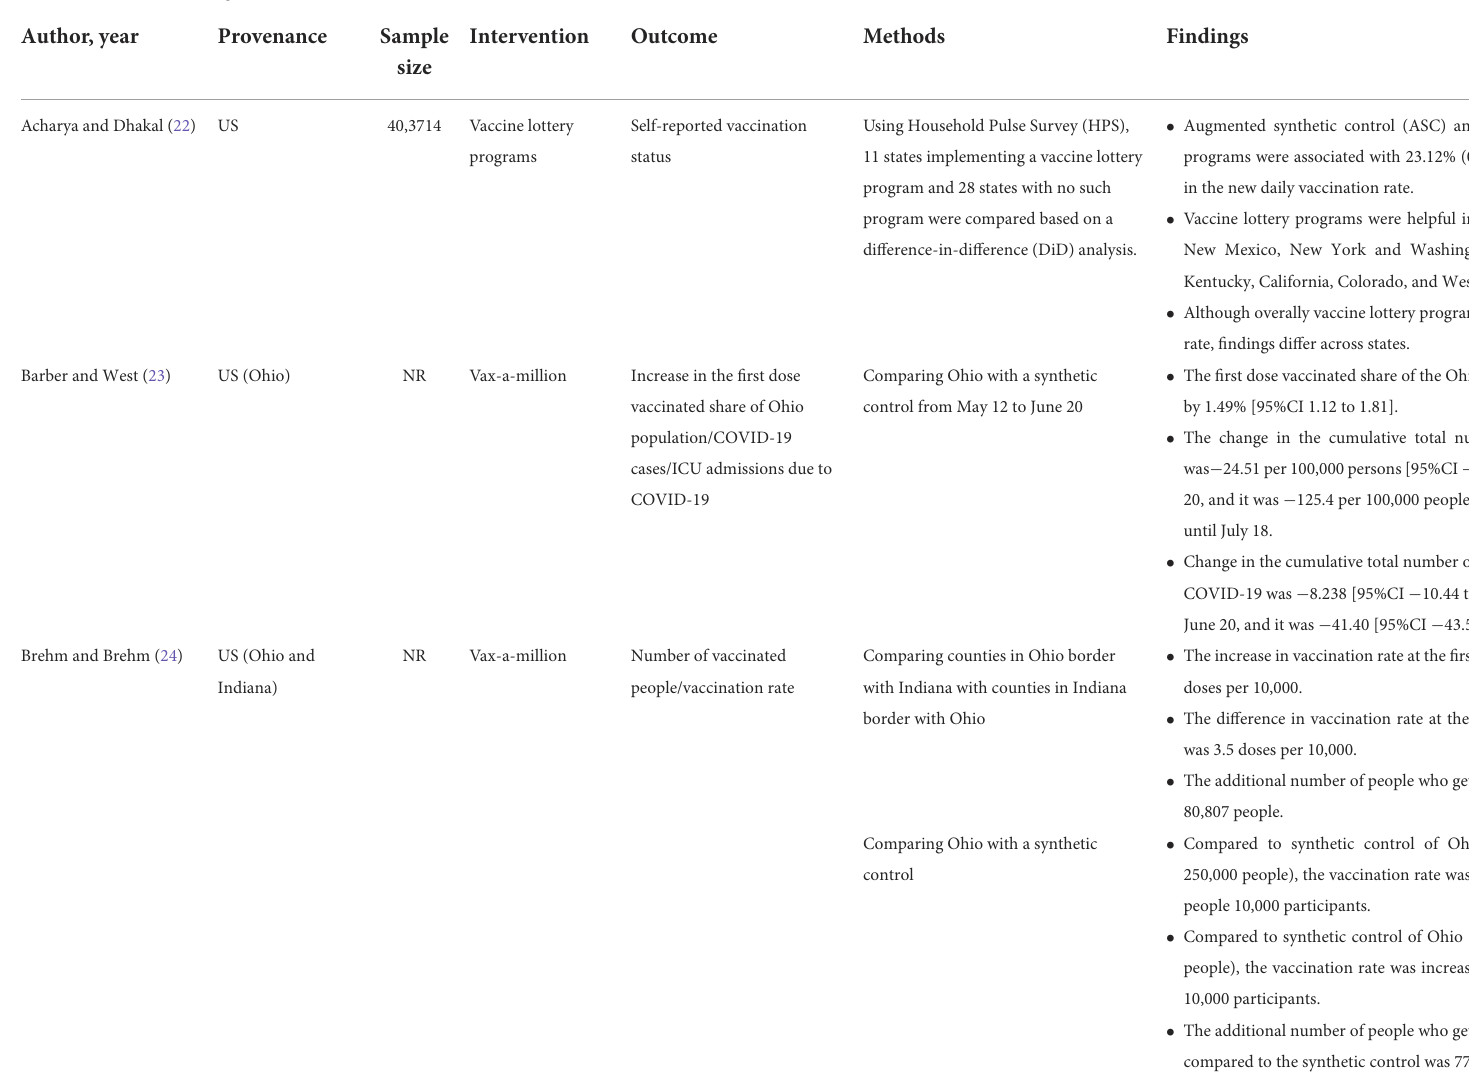
TABLE 2 Qualitative analysis of included